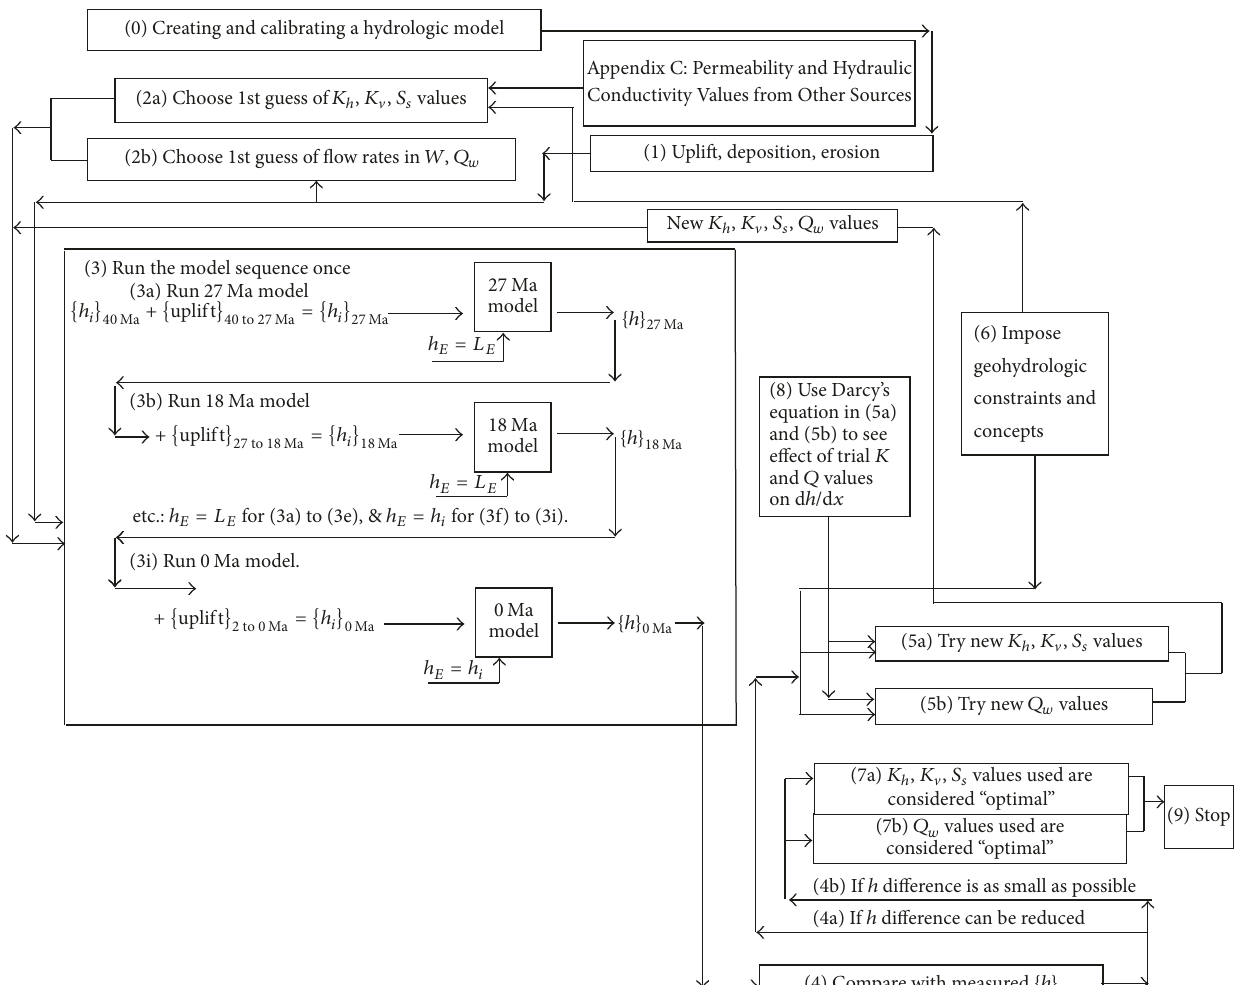
Figure 13: Flow chart of the modeling process. ℎ 𝐸 : head specified in east; 𝐿 𝐸 : Land surface elevation in the east; ℎ 𝑖 : interpolated ℎ between {ℎ} ℎ contour in 𝐸 for layers (1) to (7) , and between {ℎ} 4.5 Ma and Wolfcampian Box numbers in the figure after step (4) are for labelling and are not strictly